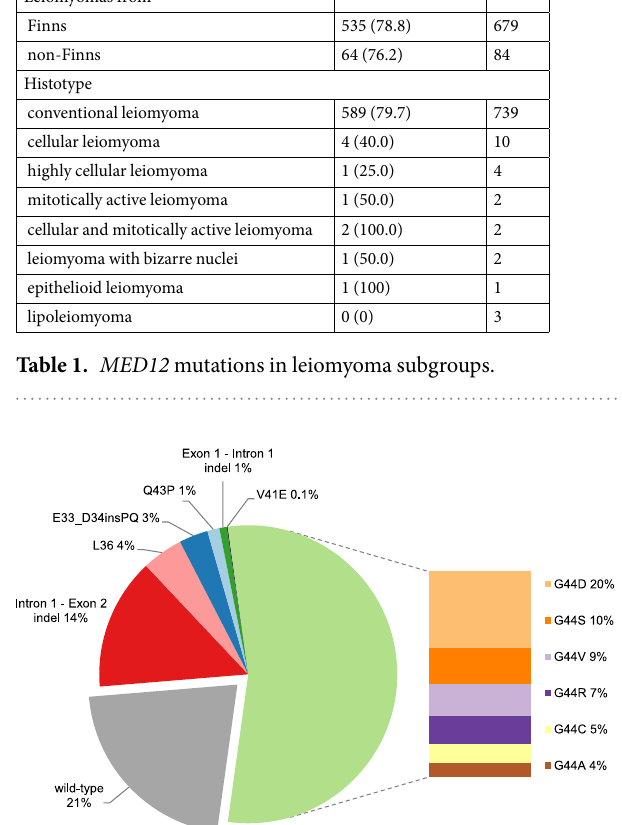
Figure 1. MED12 -mutation spectrum in 763 uterine leiomyomas. In addition to negative mutation status (wild-type), missense mutations affecting different codons, and in-frame insertion and/or deletions (indel)